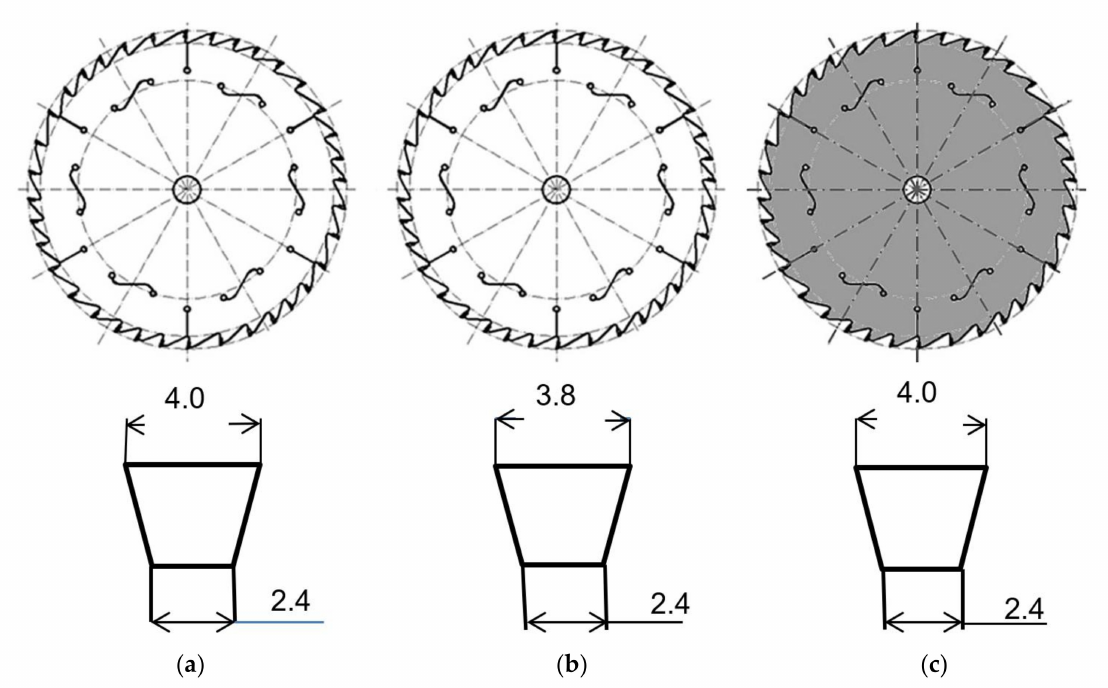
Figure 2. The structural differences of the circular saw blades used for experimental